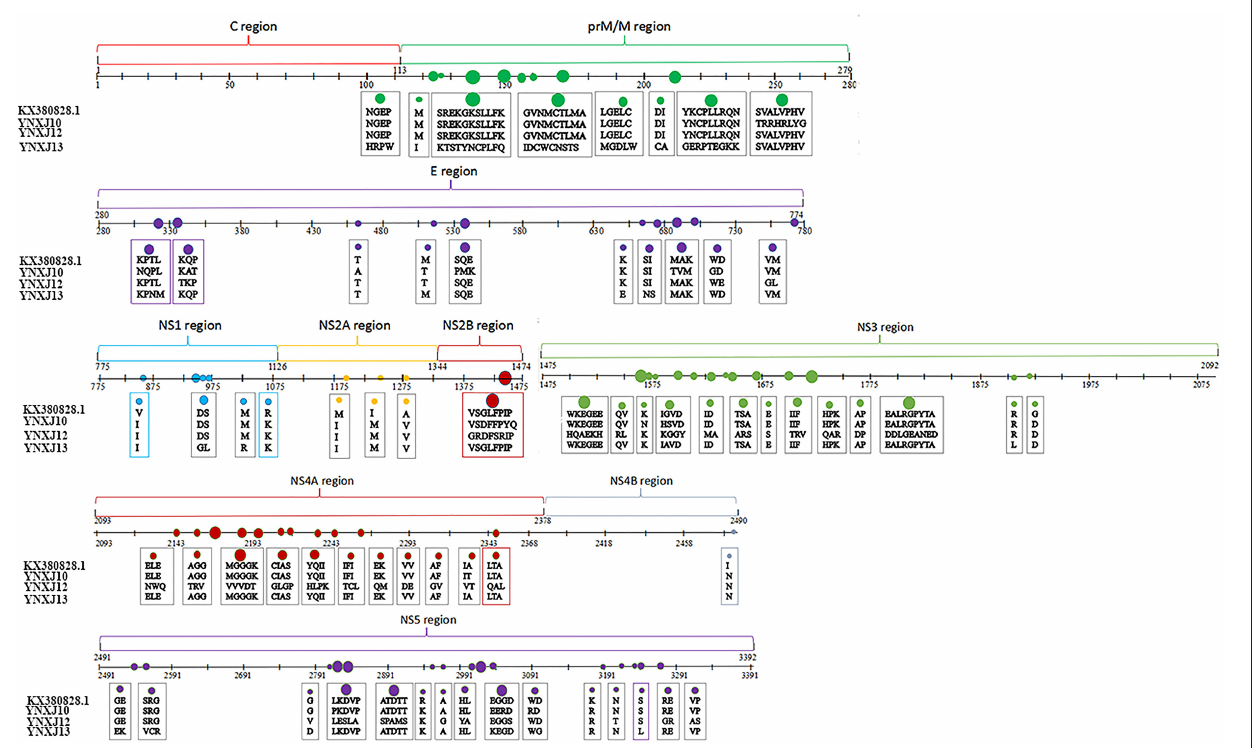
FIGURE 3 | Amino acid substitutions of YNXJ10, YNXJ12, and YNXJ13 compared to the closely-related Singapore in 2013 (KX380828.1). The first line is KX380828.1, and the second to fourth lines are YNXJ10, YNXJ12, YNXJ13, respectively. The labeled numbers represent the amino acid position.